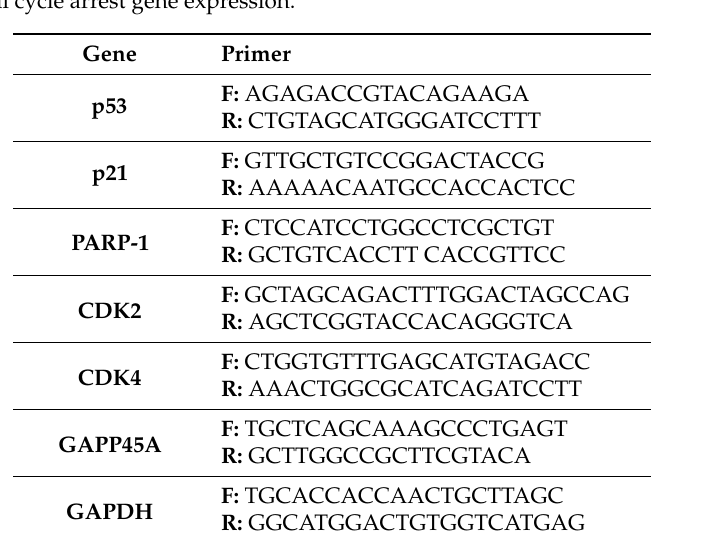
Table 2. List of primers used for quantitative real-time polymerase chain reaction for analysis of apoptotic and cell cycle arrest gene